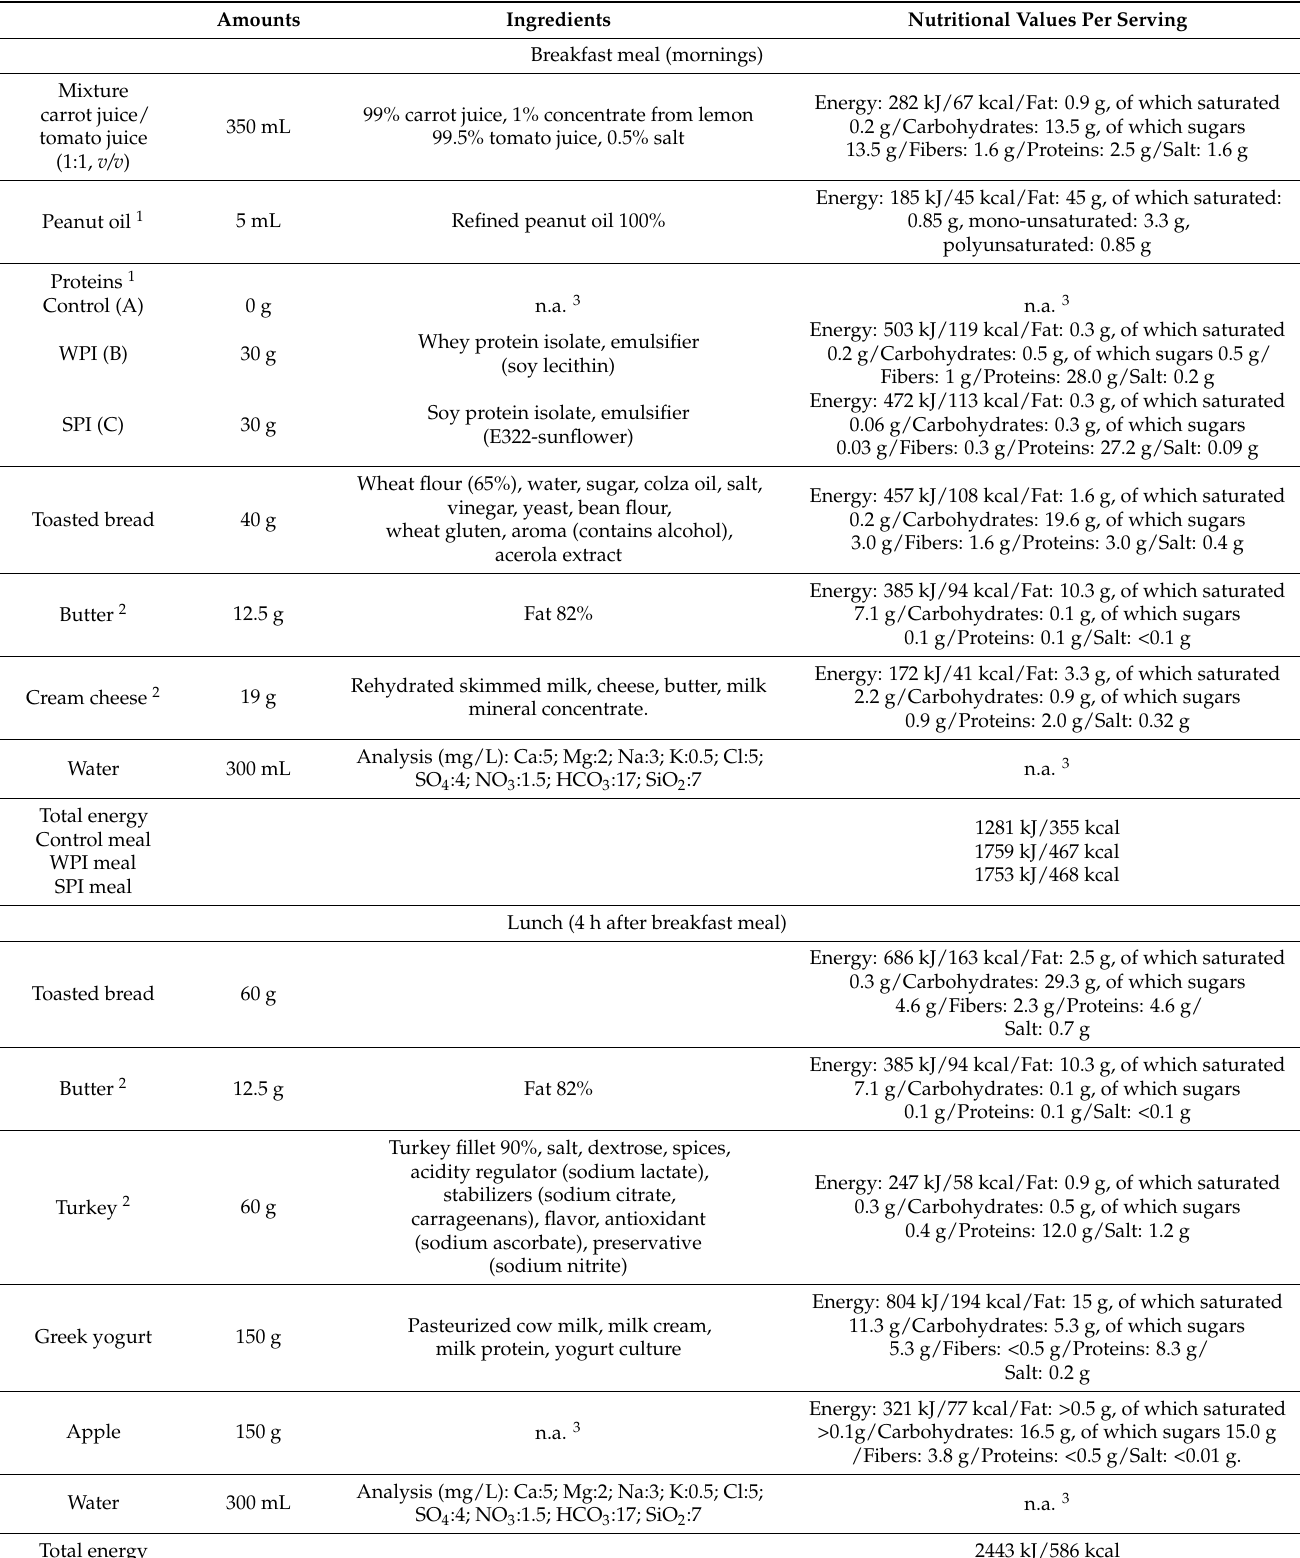
Table 2. Composition of test